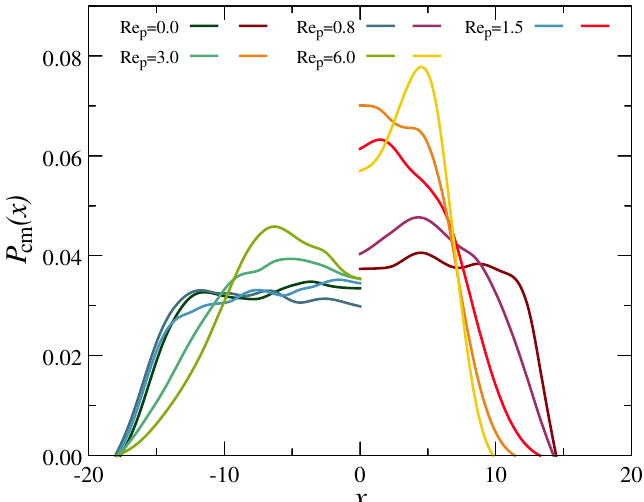
Figure 3. Center of mass probability distribution normal to the channel walls, P cm ( x ) , for a chain ( left ) and a star with f = 30 arms ( right ) at various flow strengths Re p , as indicated.